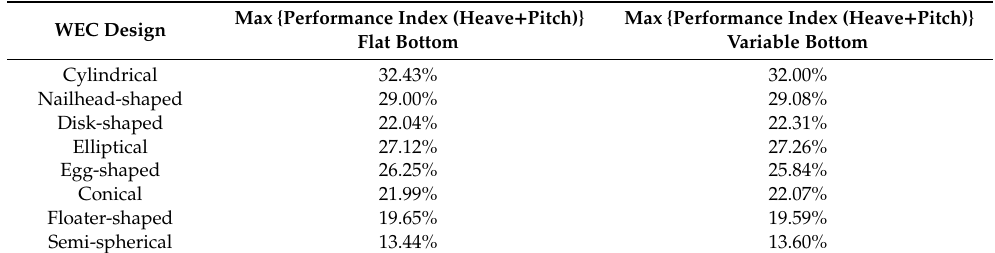
Table 2. 2-DOFs WEC shapes and PI for flat and variable bottom topographies ( h 1 = 1.2 m, h 3 = 0.8 m, α = 0.5). bot